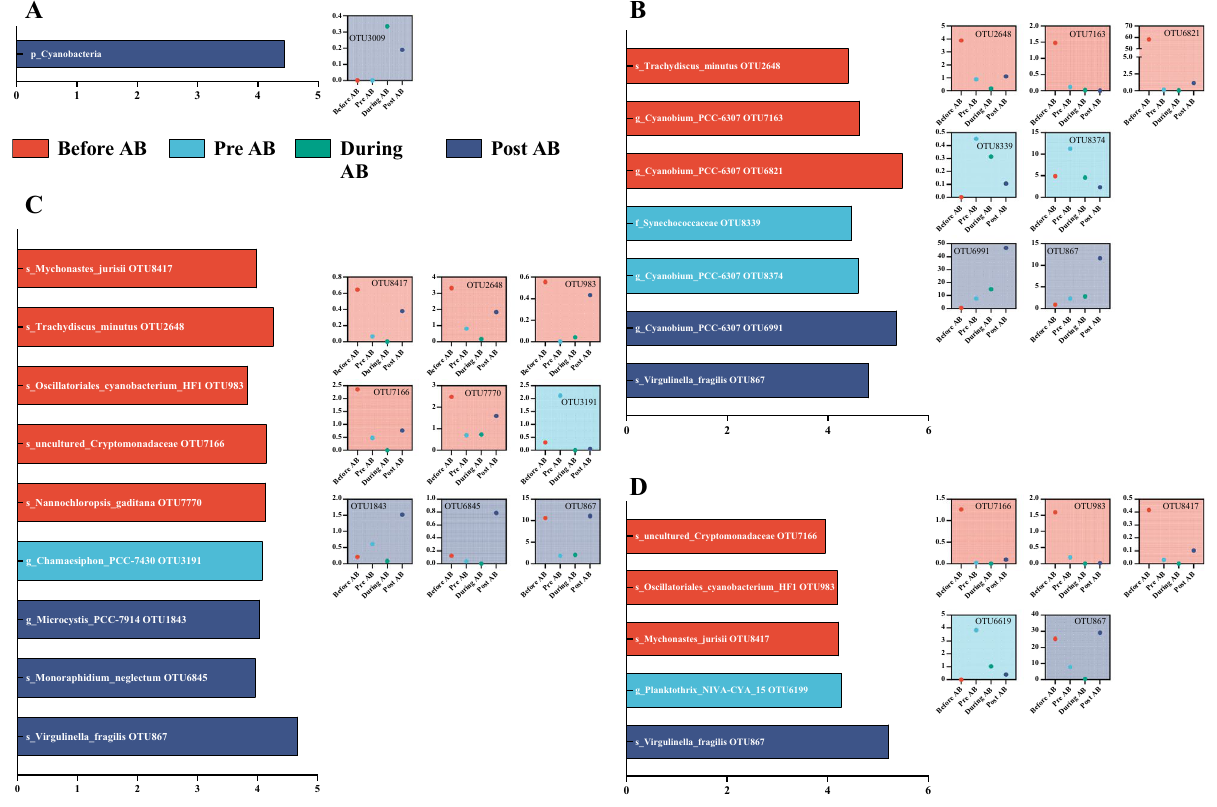
Figure 5. Significant cyanobacterial species (OTUs) based on significant and LEfSe analyses. Figures of ( A – D ) represented HS, JFZ, SH, and XH rivers. Bar plots exhibited LDA scores of each OTU, with its clearest phylogenetic level, and the scattered dot plots illustrated the dynamic changes of each OTU’s relative